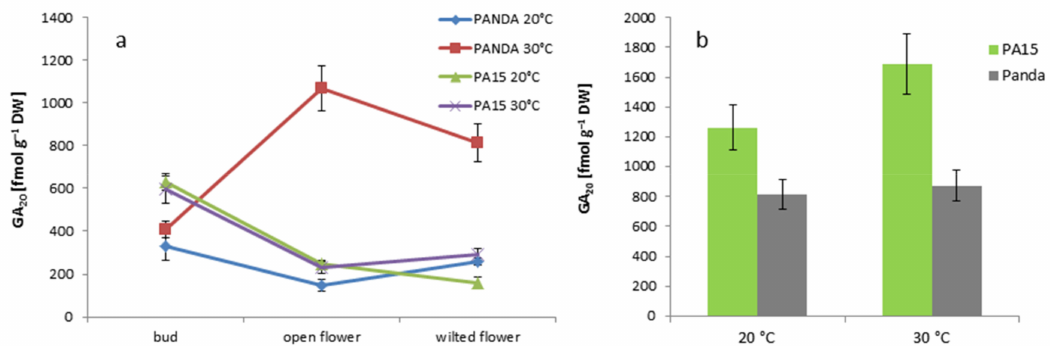
Figure 8. Content of non-active gibberellin GA 20 [fmol g − 1 DW] in the flower buds, open flowers, and wilted flowers ( a ) and the leaves ( b ) of the ‘Panda’ and PA15 plants grown at 20 ◦ C (control) and 30 ◦ C (thermal stress). Means ( n = 3) ± SE.